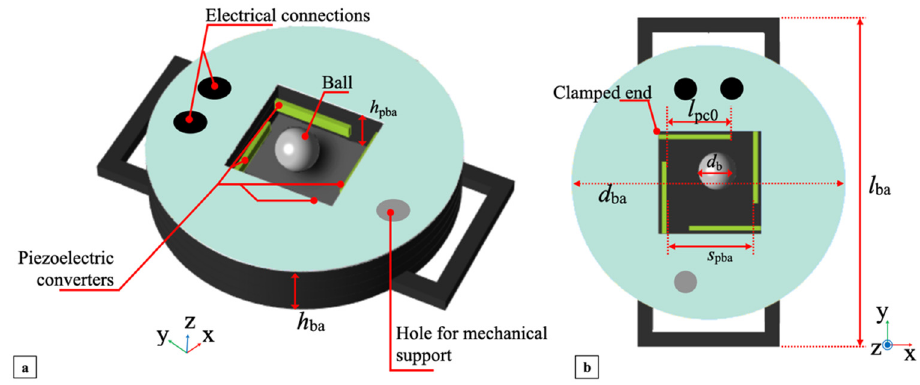
Figure 3. 3D view ( a ) and top view ( b ) of the bi-axial multi-converter piezoelectric harvester.